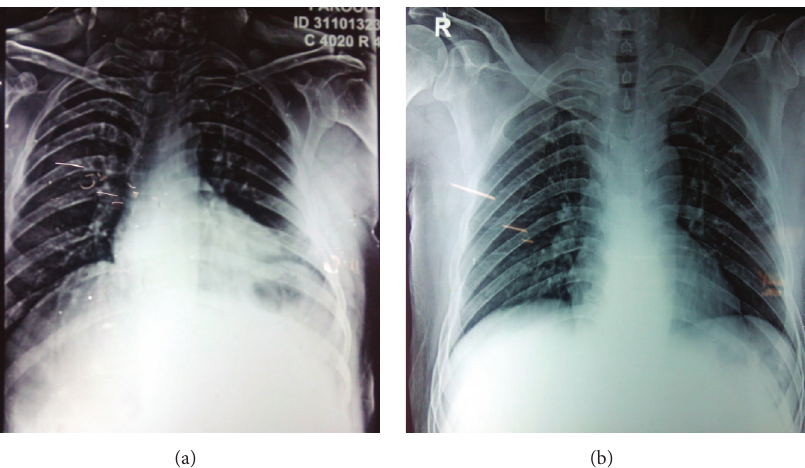
Figure 1: A chest X-ray on (a) showing left lower zone infiltrates. Chest X-ray on (b) at the time of discharge showing improvement.